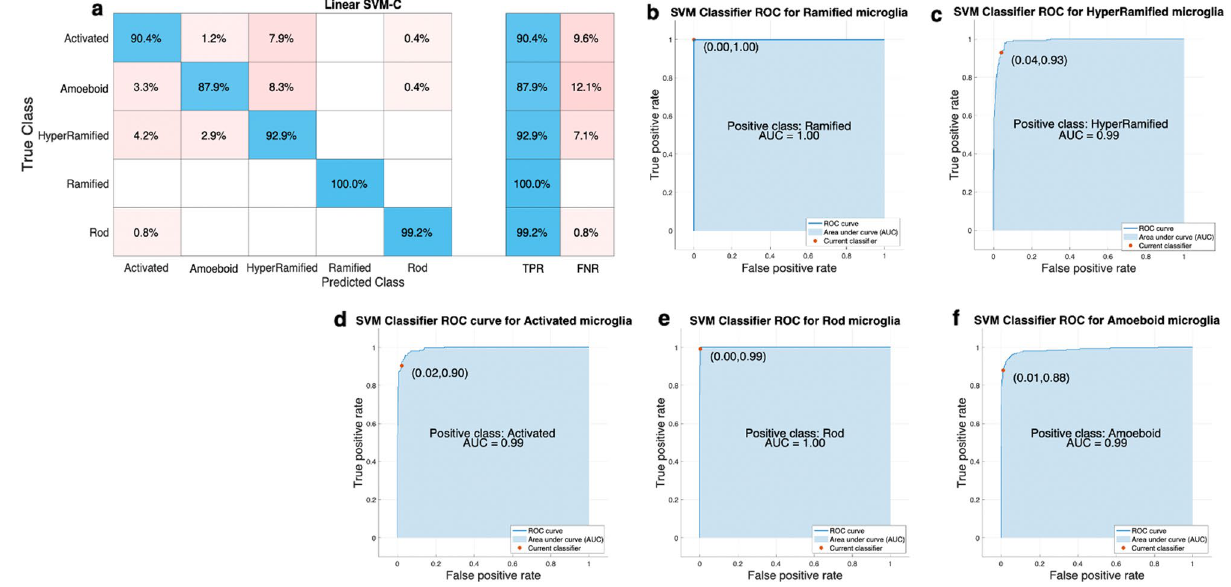
Figure 4. SVM Classifier Confusion Matrix and ROC Curves. ( a ) shows a confusion matrix of the trained SVM Classifier. The rows display the ‘True Class’ and the columns the ‘Predicted Class’. The diagonal cells in blue display the correctly classified observations. The other pink shaded cells display the incorrectly classified observations. TPR True Positive Rate, FNR False Negative Rate. ( b – f ) show the receiver operating characteristic (ROC) curves of the TPR against the false positive rate (FPR) for ramified ( b ), hyper-ramified ( c ), activated ( d ), rod ( e ) and amoeboid ( f ) microglia.